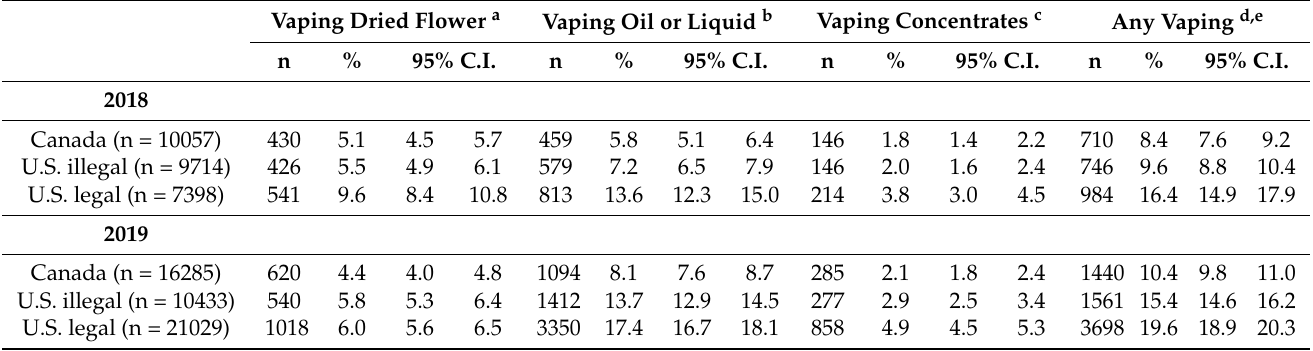
Table 1. Past year proportion of cannabis vaping, by product and jurisdiction. Vaping Dried Flower a Vaping Oil or Liquid